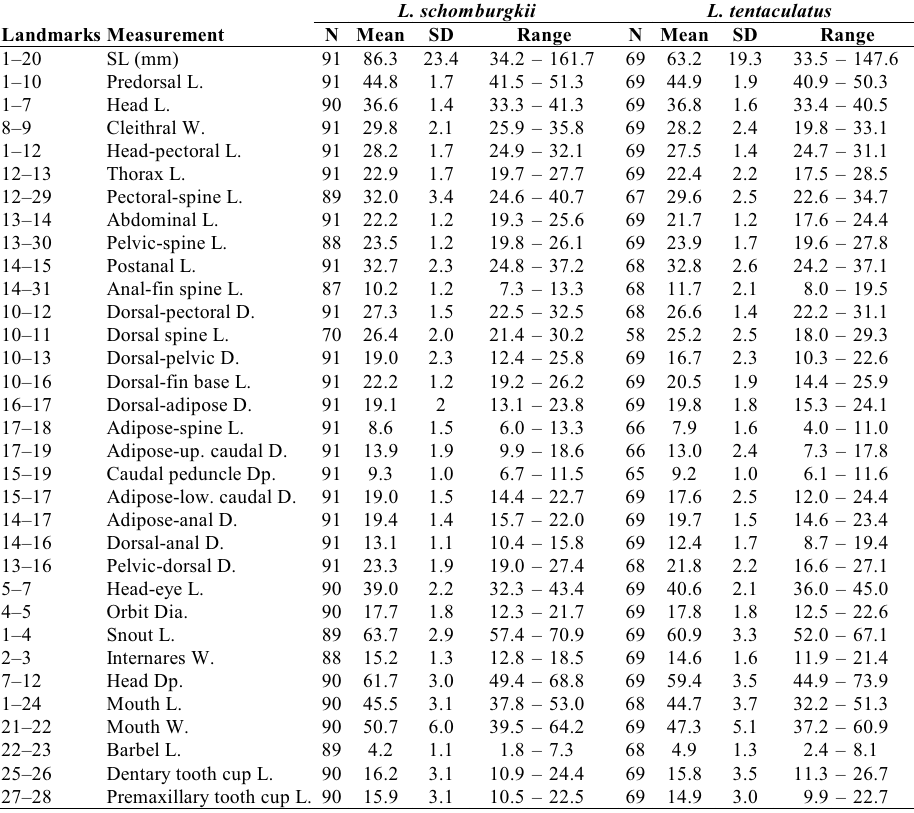
Table 3. Selected morphometrics of Lasiancistrus schomburgkii and L. tentaculatus . Ratios are percent of SL (Predorsal L. to Pelvic-dorsal D.) or percent of Head L. (Head-eye L. to Premaxillary tooth cup